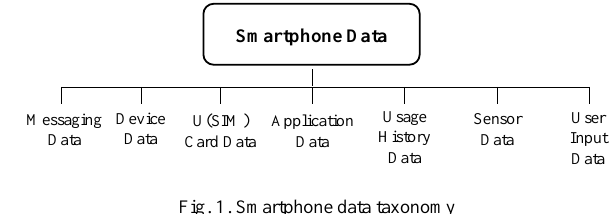
Fig. 1. Smartphone data